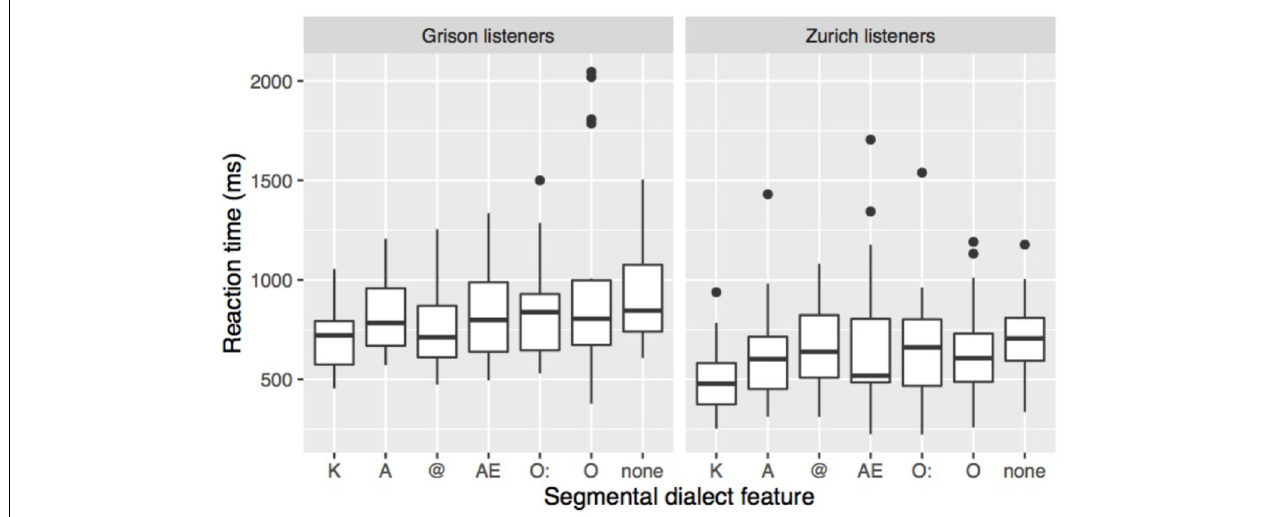
FIGURE 6 | RT in response to the different segmental dialect features in the stimulus. Stimuli with two segmental dialect features have been removed prior to averaging response times over listener and dialect